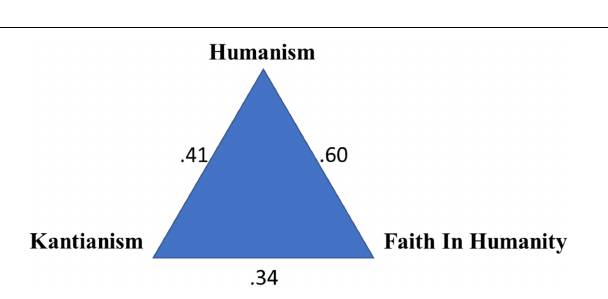
FIGURE 2 | Confirmatory factor analysis on select 12 light triad items in combined sample. N = 1,518.